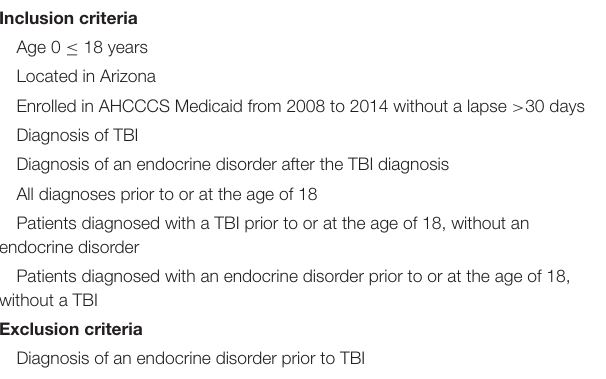
TABLE 1 | Inclusion/exclusion criteria for the sample population. Inclusion criteria